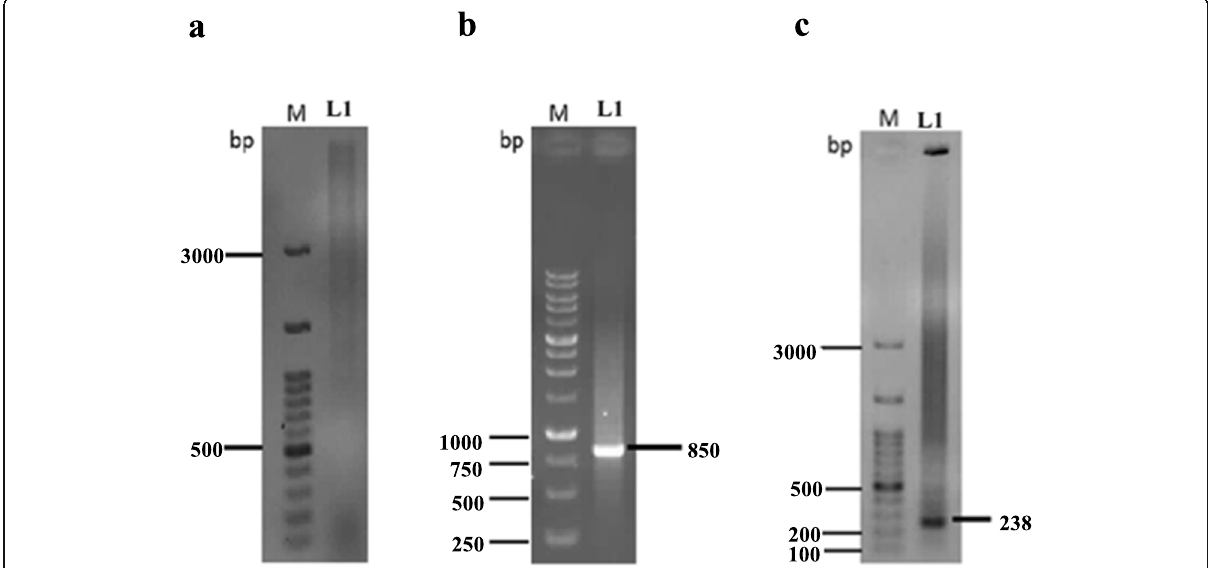
Fig. 3 Amplification of PCR fragments using different primers. a GSP1 and AP1 primers in the first PCR. M, DNA ladder; L1, first PCR product amplified from the upstream region of map30 gene. b GSP2 and AP2 (nested primer) primers in the second PCR. M, DNA ladder; L1, second PCR product amplified from the upstream region of map30 gene. c GSP1 and F helper primers. M, DNA ladder; L1, third PCR